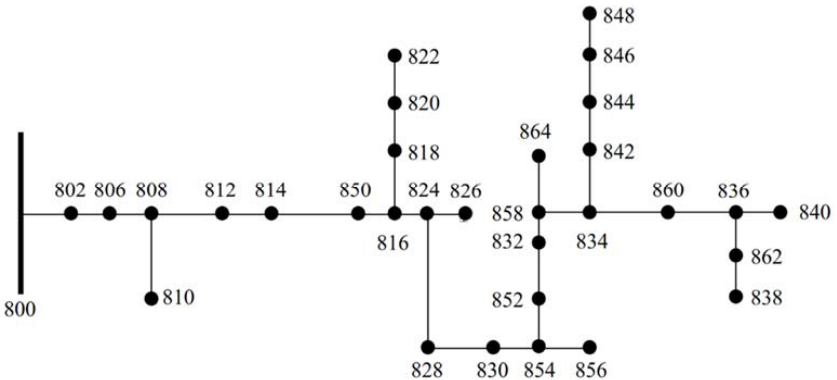
Figure 5. IEEE 34 ‐ bus test system. Figure 5. IEEE 34-bus test